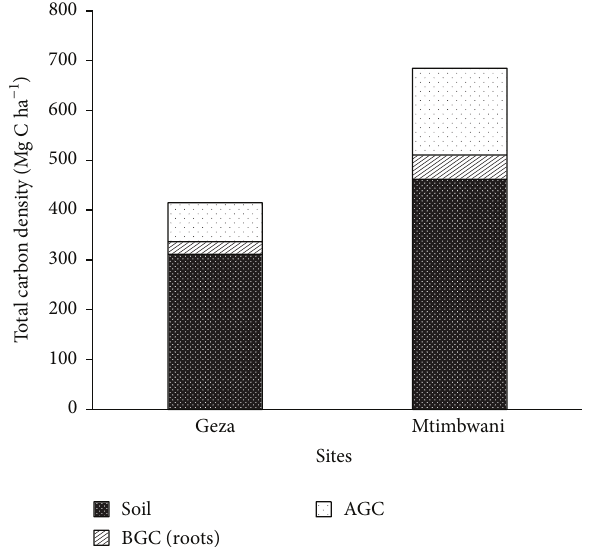
Figure 4: Contribution of different carbon pools to the total ecosystem carbon